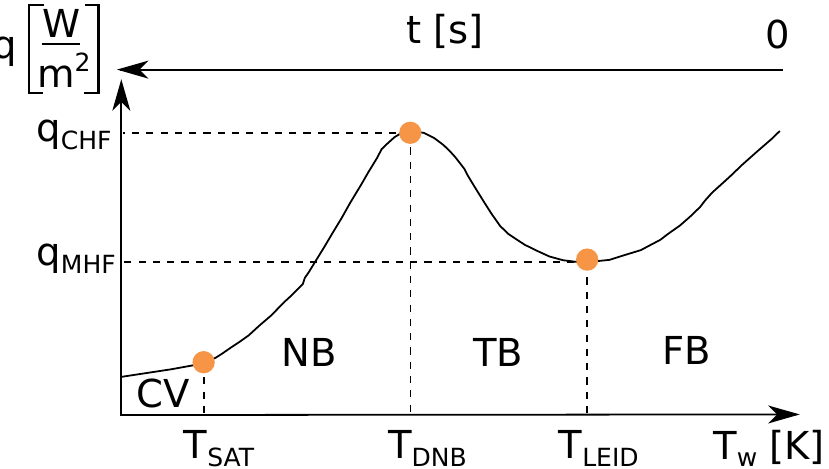
Figure 1. A schematic indicating the conditions for the various HTRs. The vertical axis shows the heat flux across the solid–fluid interface, while the horizontal axis indicates the wall temperature. The various HTRs are labelled by capital letters: FB—Film boiling, TB—Transition boiling, NB—Nucleate boiling, CV—Convective heat transfer. The various subscripts have the following meanings: LEID— Leidenfrost, DNB—a departure from nucleate boiling, SAT—saturation, MHF—minimum heat flux, CHF—critical heat